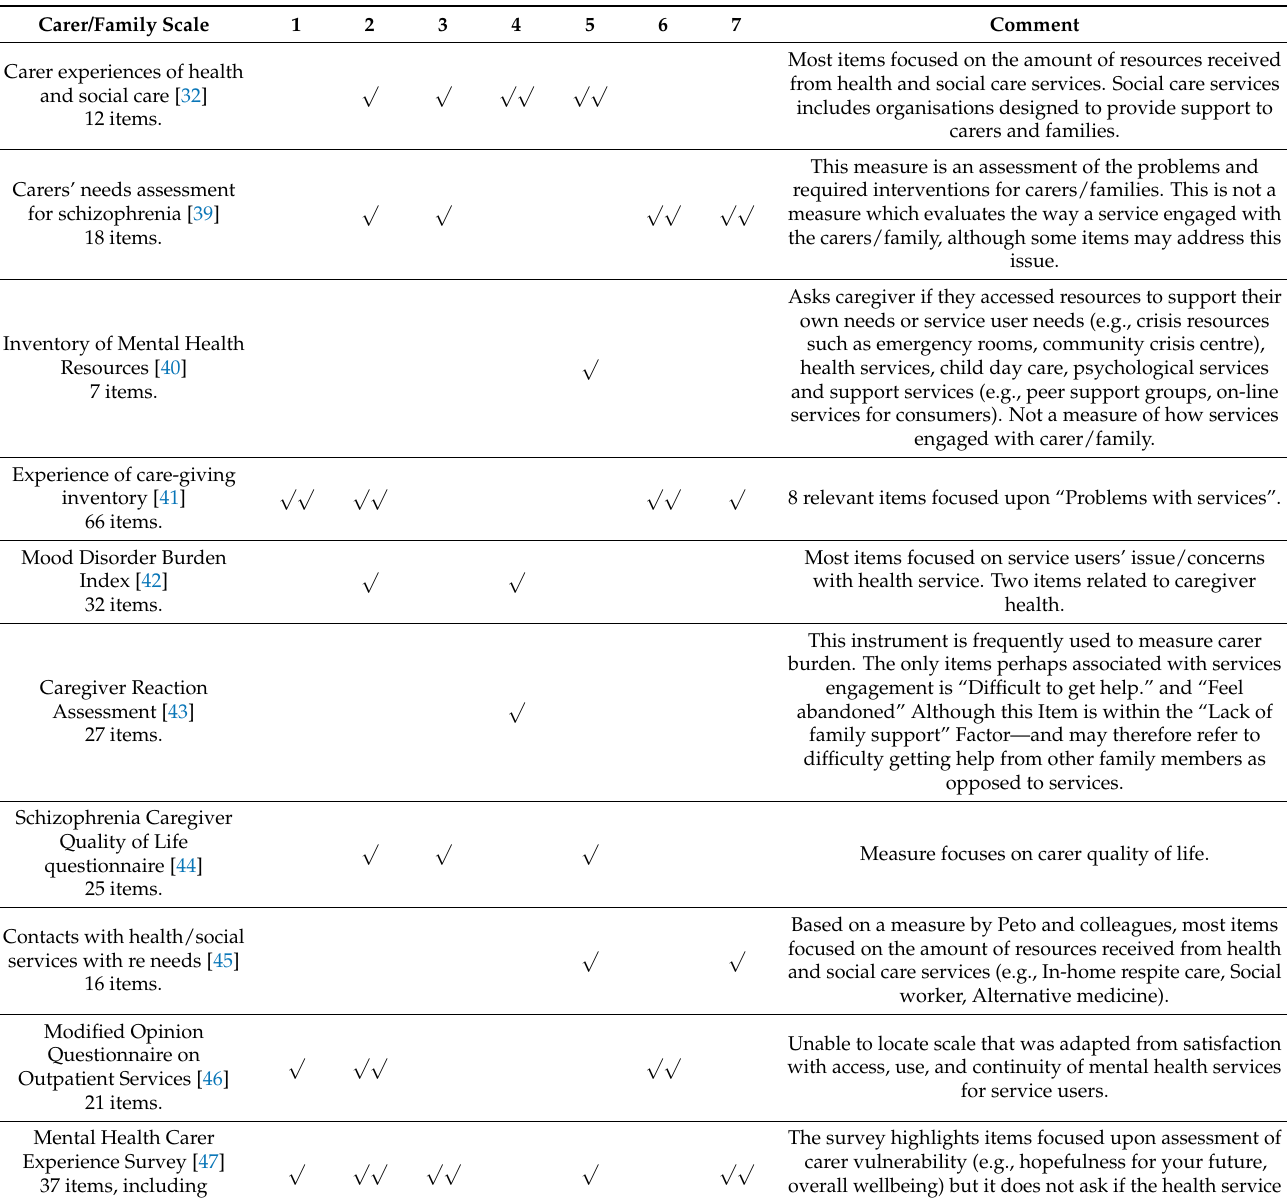
Table 1. Item content of 10 carer/family measures (as identified by [38]) as applied to the